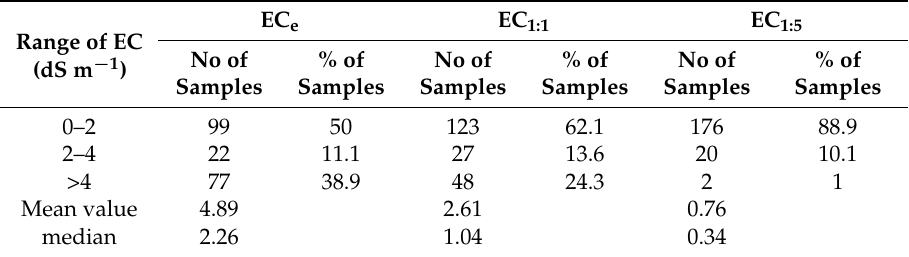
Table 2. Population of samples in the three EC classes according to EC e , EC 1:1 and EC 1:5 values (N = 198). Range of EC